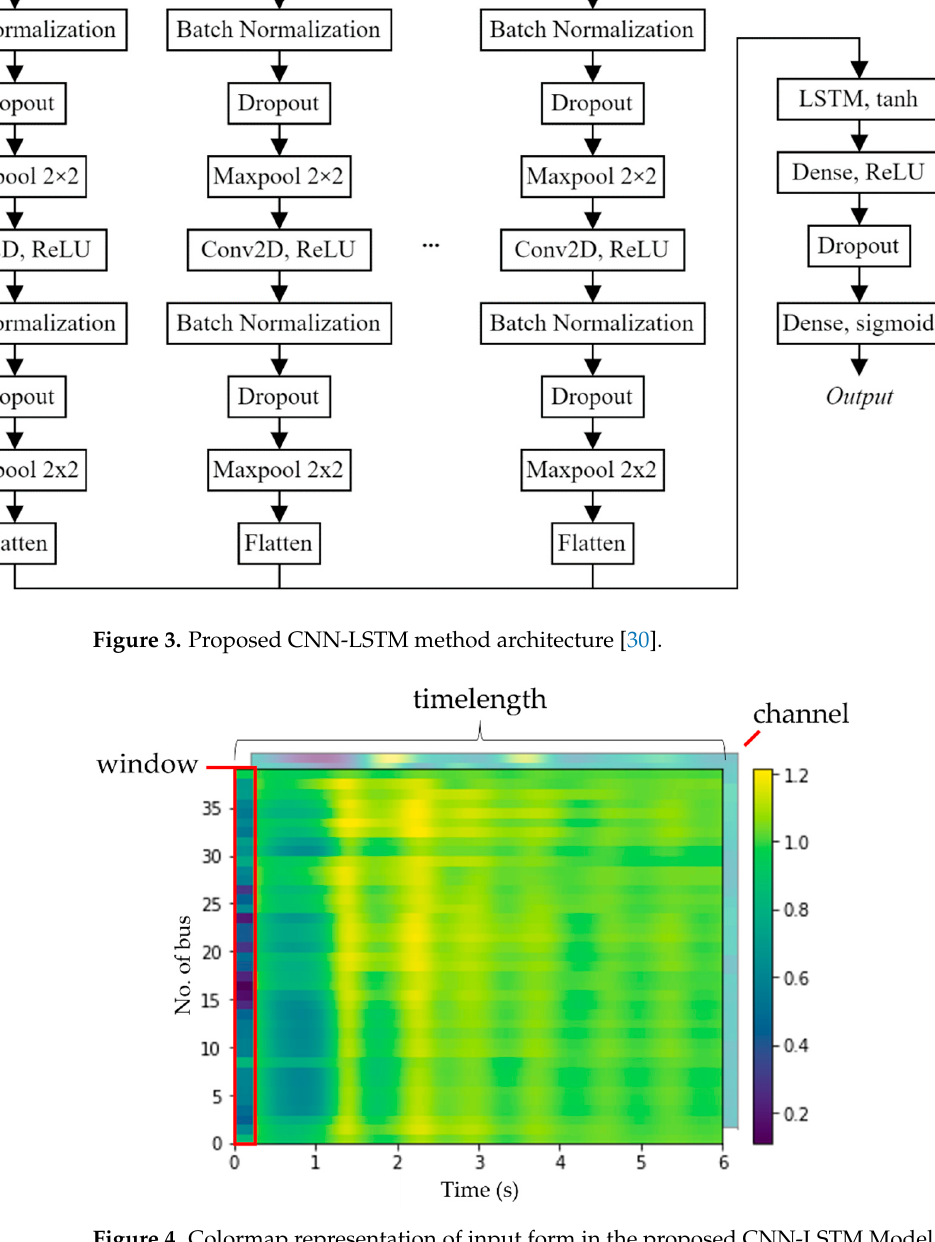
Figure 4. Colormap representation of input form in the proposed CNN-LSTM Model [30].